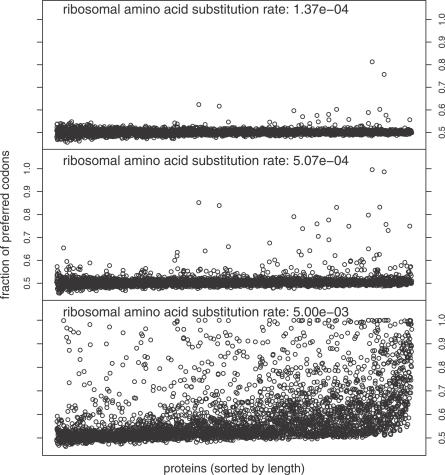
Fraction of Preferred Codons  After Selection for Three Different Ribosomal Amino Acid Substitution Rates ur
The genes are sorted according to the length of the protein. For ur = 1.37 × 10−4, selection introduces a codon bias only for few genes (compare with m-neutralities in Figure 6). An increase in the phenotypic mutation rate leads to more intensive selection for preferred codons in large genes than in small genes.